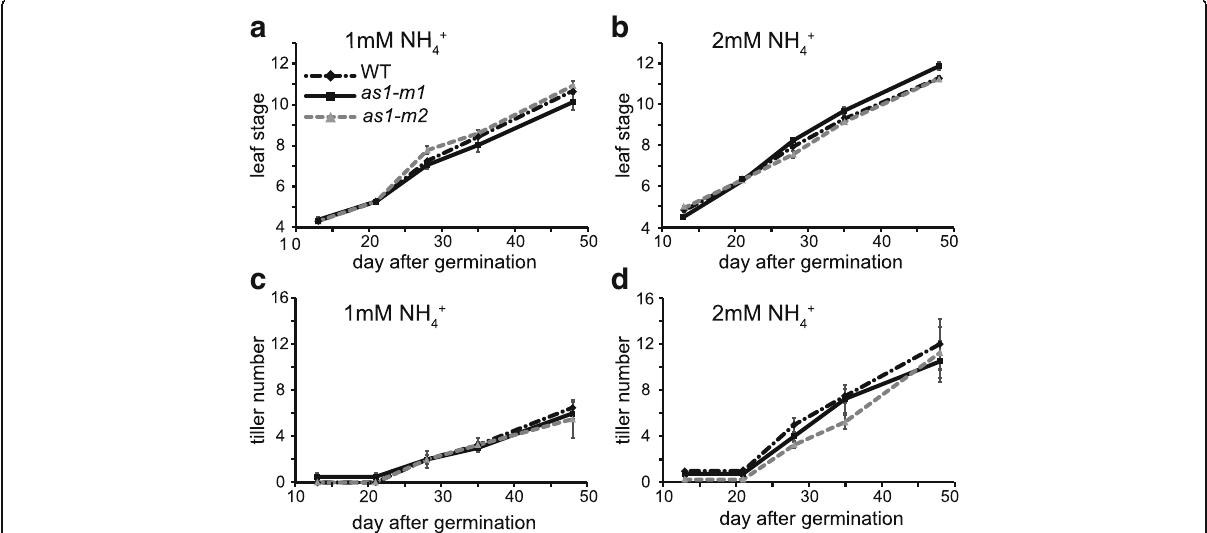
Fig. 7 Comparison of leaf stage and tiller number between the wild type and as1 mutants. Wild-type (WT: black diamond) plants and two lines of as1 mutants ( as1-m1 and as1-m2 : black square and grey triangle, respectively) were grown hydroponically in the presence of 1 mM ( a , c ) or 2 mM NH 4 Cl ( b , d ) until 50 days after germination. Time course studies on measurements of leaf stage and tiller number were conducted. Mean values with SE of four independent samples are shown. One-way ANOVAs followed by Bonferroni tests were used to identify significant differences between the wild type and as1 mutants ( P <0.05)